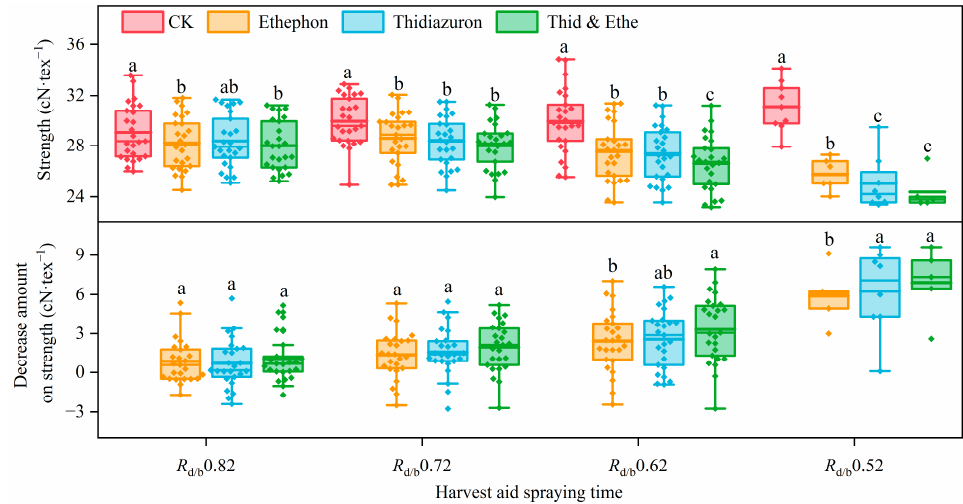
Figure 7. Effects of harvest aid and spraying time on fiber strength. The thick solid line in the figure indicates the average value. The different letters indicate significant differences between harvest aid treatments at the same spraying time ( p < 0.05). When spraying occurred at R d/b 0.52, the number of samples was 9, and the number of other samples was 25. The micronaire value was significantly affected by the harvest aids (Table 5). The micronaire value was 3.90 under the control and was significantly reduced by 0.74 under the ethephon treatment and by 0.93–0.97 under the thidiazuron and thidiazuron com- bined with ethephon treatment (Figure 8). The spraying time of the harvest aids had a significant effect on the micronaire value ( p < 0.0001). When the spraying time was an R d/b of 0.82, the micronaire value under the different harvest aid treatments was 3.67–4.33, mostly in the A-level range (Figure 8). When spraying occurred at an R d/b of 0.72, 0.62, and 0.52, the micronaire value decreased significantly by 0.80–1.08 when compared with the control under the different harvest aids, of which an R d/b of 0.52 decreased the most, and the micronaire value was only 2.77 (Figure 8).